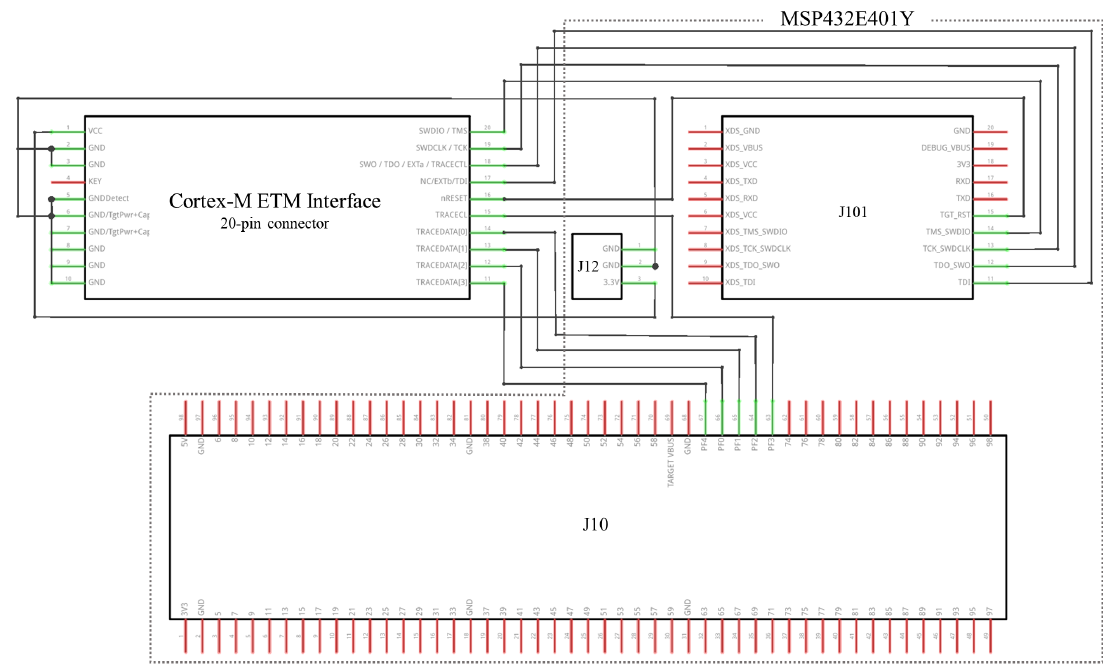
Figure 3. Custom